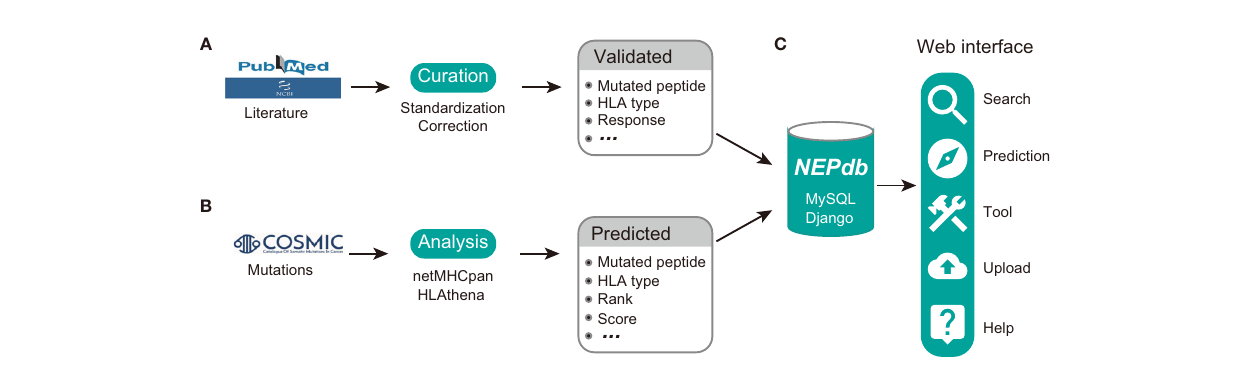
FIGURE 1 | NEPdb content and construction. (A) Manual collection and curation of experimentally validated neoepitope and non-immunogenic peptides information. (B) Computational analysis of HLA-peptides for pan-cancer gene mutations. (C) Database implementation and overview of the web